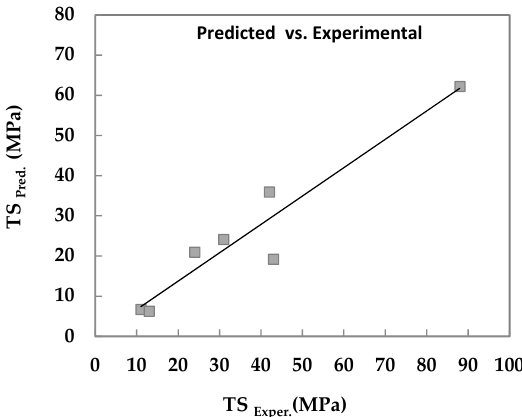
Figure 5. Comparison of the experimental with predicted values of tensile strength.